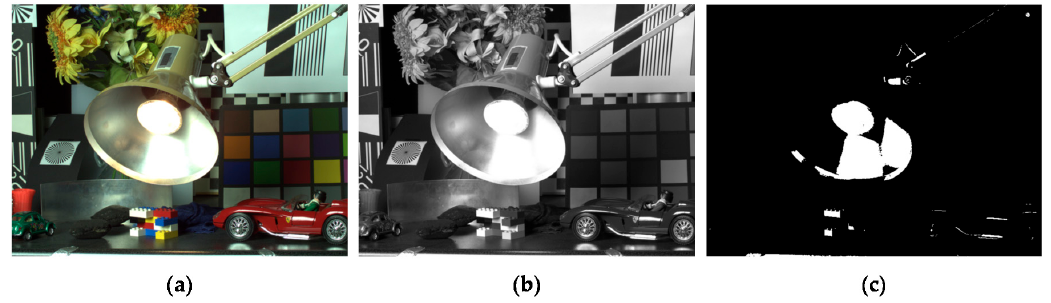
Figure 4. ( a ) Input MV LDR image, I m ; ( b ) luminance channel of I m and L m ; and ( c ) under/over-exposed region map, S .